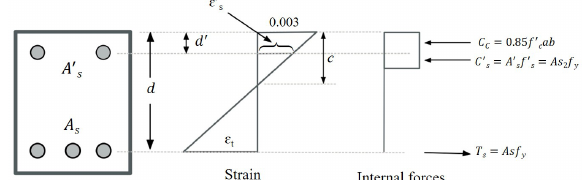
Fig. 1. Internal strains and forces for doubly reinforced rectangular